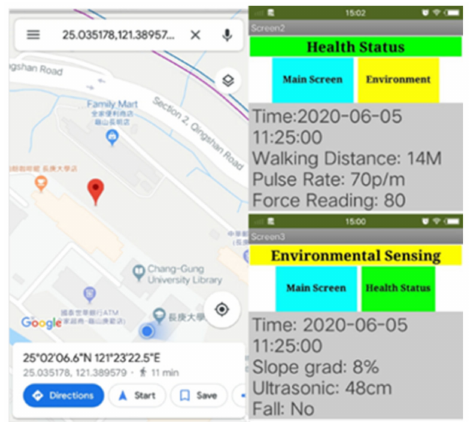
Figure 17. App showing: User’s location, user’s health status and environmental information encountered by smart